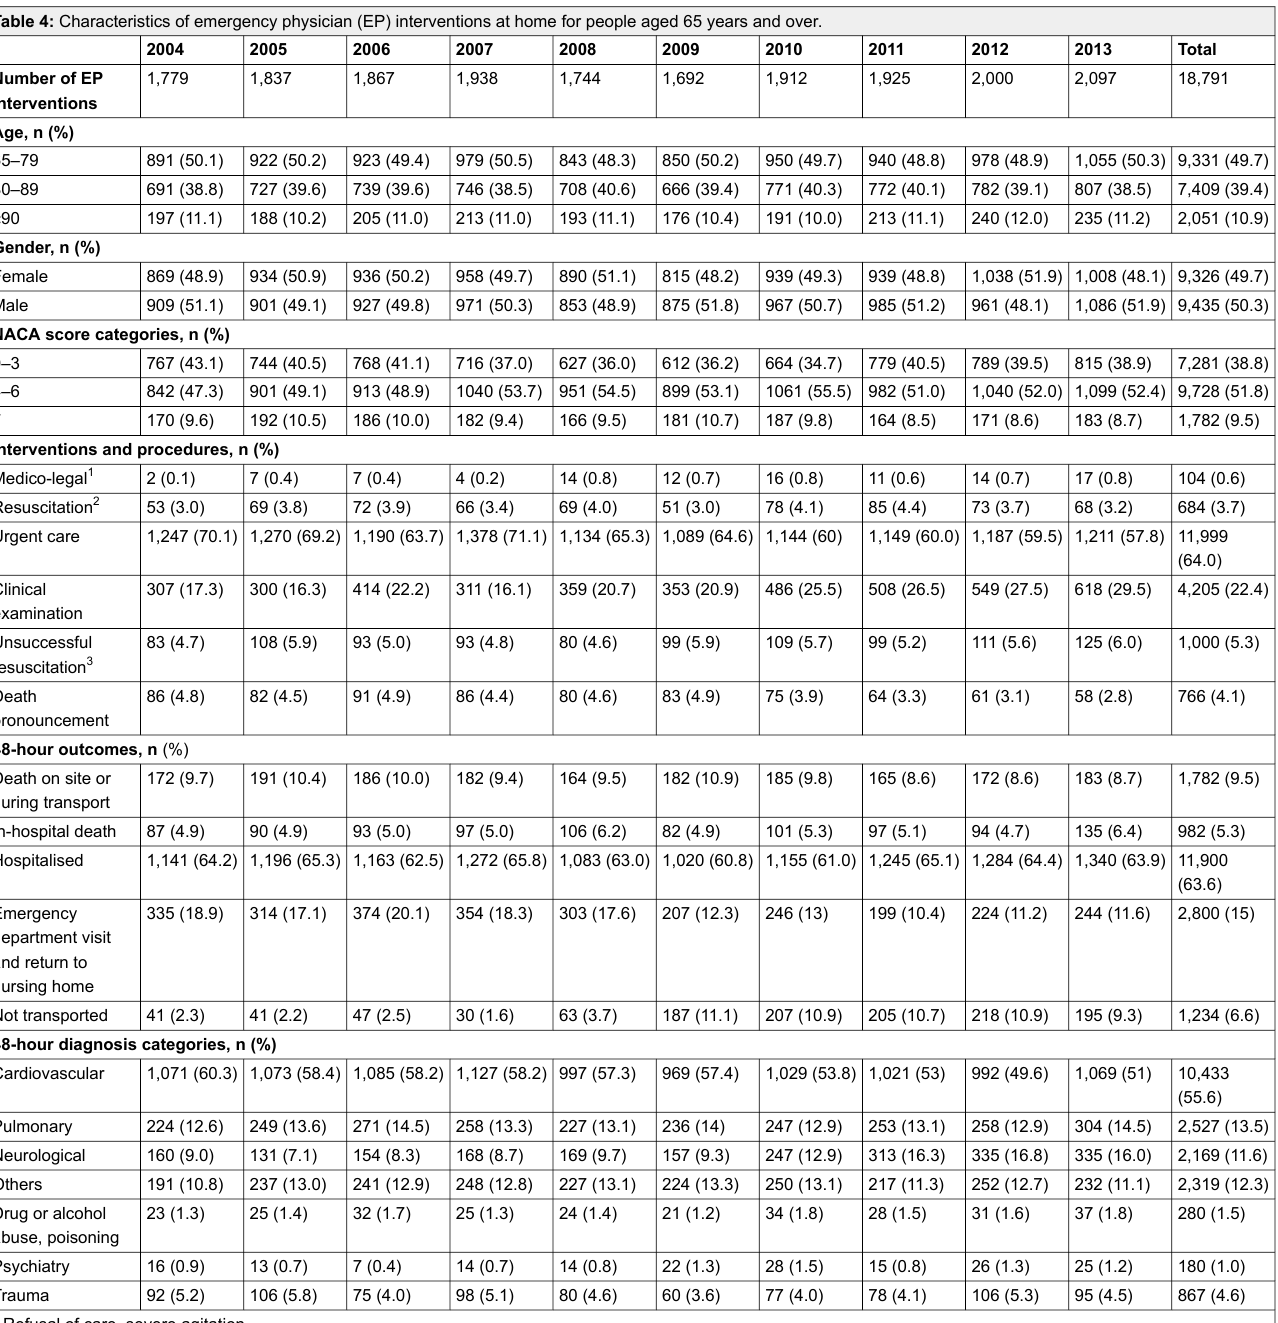
Table 4: Characteristics of emergency physician (EP) interventions at home for people aged 65 years and